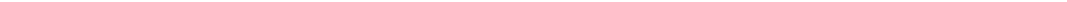
Fig. 5 Identi fi cation of key molecular features for HCC subtypes. a Differentially mutated genes among the subtypes of LIHC are shown. A total of 37 differentially mutated genes are identi fi ed, which have differential mutation rates in C1 tumors compared to C2 or C3 tumors, respectively. The two samples of TCGA-G3-A25X-01 and TCGA-BC-4072-01 with no mutation data were excluded in the analysis (indicated with a right grey color). b Network of CNVcor genes is constructed using physical and genetic interactions from GeneMania software, which identi fi es the highest interconnecting hub gene, UBC. c Heatmaps show the differentially up- (DEG_UP, n = 121) and down-expressed (DEG_DOWN, n = 366) genes that are commonly found in both SNU and LIHC data sets, respectively (top). Top-ranked DEGs are indicated. The DEGs for SNU data are de fi ned with fold difference > 1.4 in comparison of iCl1 tumors with iCl2 or iCl3 tumors, while the DEG for LIHC data are de fi ned with fold difference > 2 and permuted Student ’ s t test P < 0.001 in comparison of the C1 tumors compared to C2 or C3 tumors, respectively. Gene set enrichment scores of the embryonic stem cell (ESC)-related gene sets (middle) and the nine molecular classi fi ers for HCC (bottom) are shown in SNU and LIHC data sets, respectively. Stemness gene sets of ESC, Nanog, Oct4, Sox2, Myc1, and Myc2, and the nine different HCC classi fi ers are obtained from previous studies as described in “ Methods. ” d Huh7 cells stably expressing non-targeting (NT) shRNA and BAP1 shRNA (#489 or #1735) were established. Real time qPCR for BAP1 and stemness genes ( CA9 , KRT19 , EPCAM , and PROM1 ) was performed. The expression values represent means ± S.E.M. of three independent